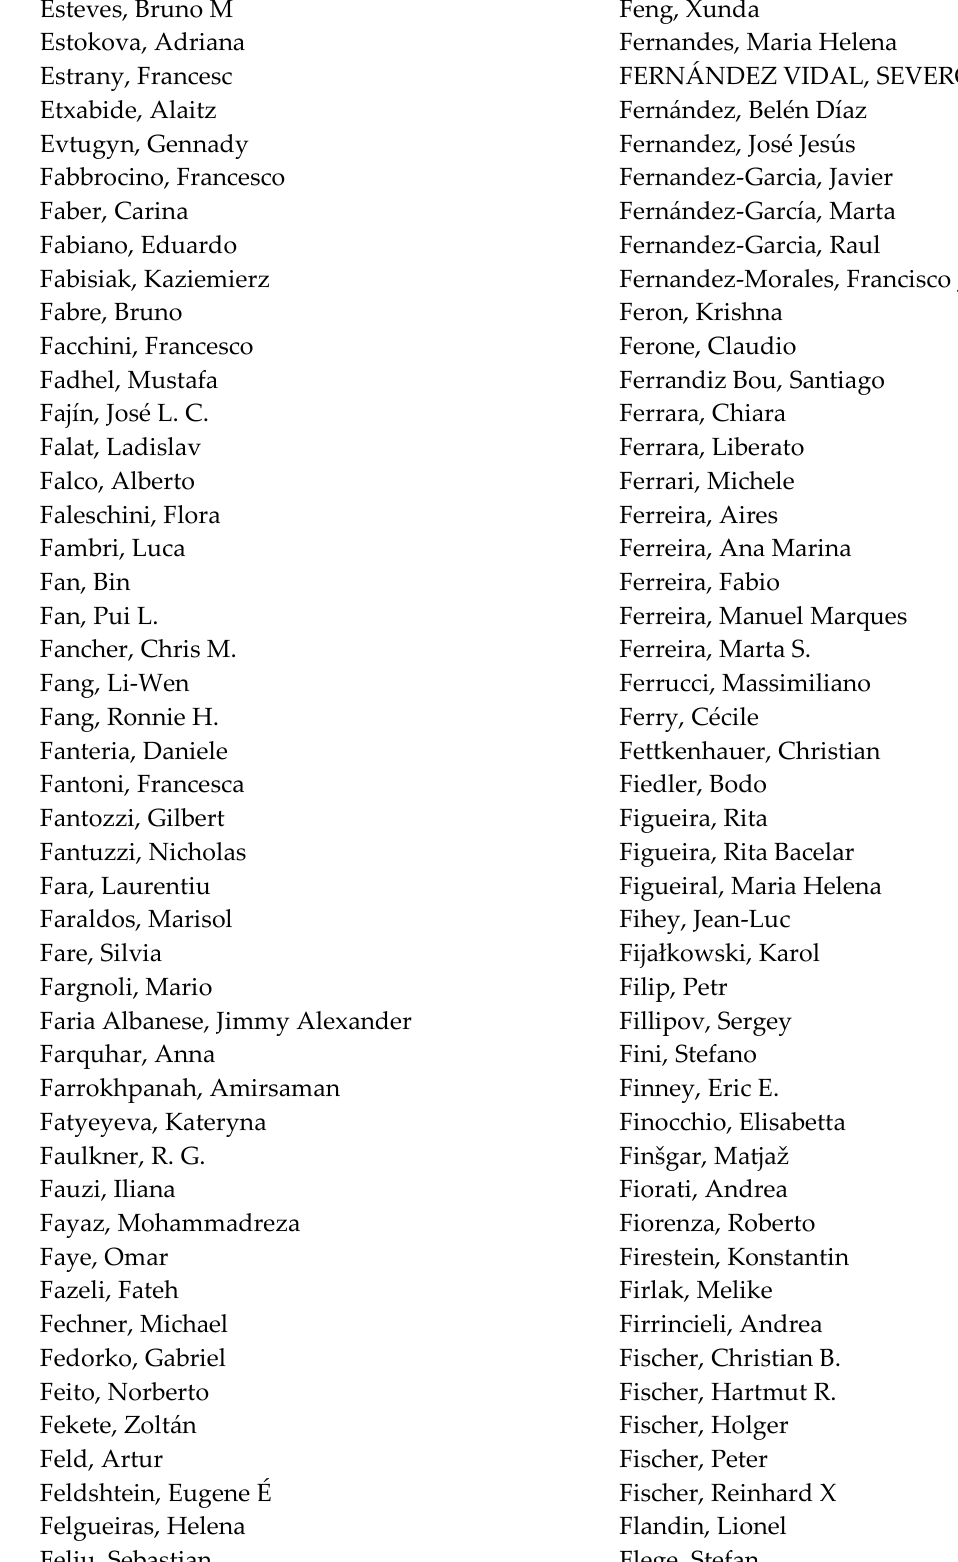
Figueira, Rita Figueira, Rita Bacelar Figueiral, Maria